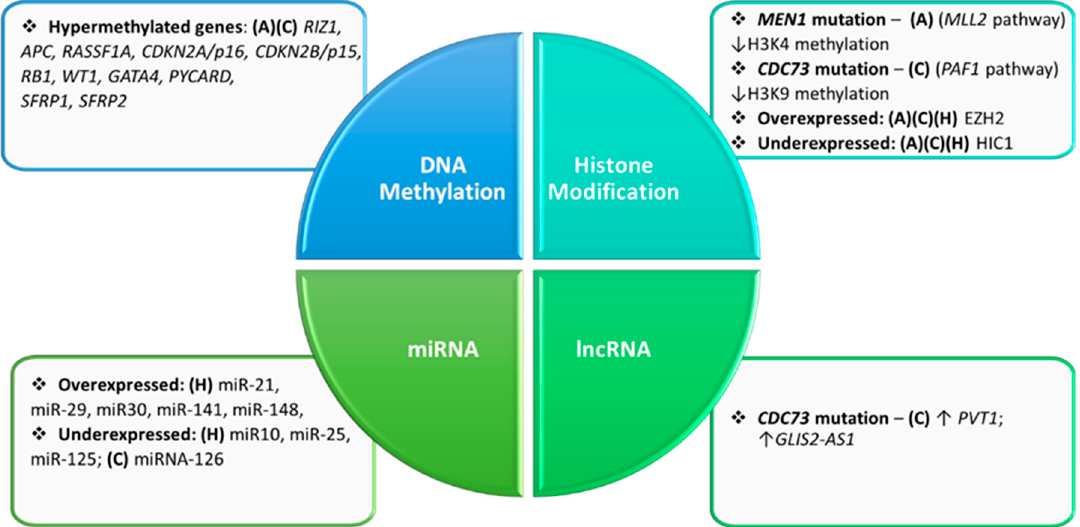
Figure 1. Diagram showing critical molecules related to epigenetic features of adenomas (A), carci- noma (C), and hyperplasia (H) of parathyroid glands. The epigenetics data are presented according to mechanism modality (DNA methylation, histone modification, microRNA (miRNA), and long noncoding RNA (lncRNA)) associated with the most relevant findings related to parathyroid tu- morigenesis.